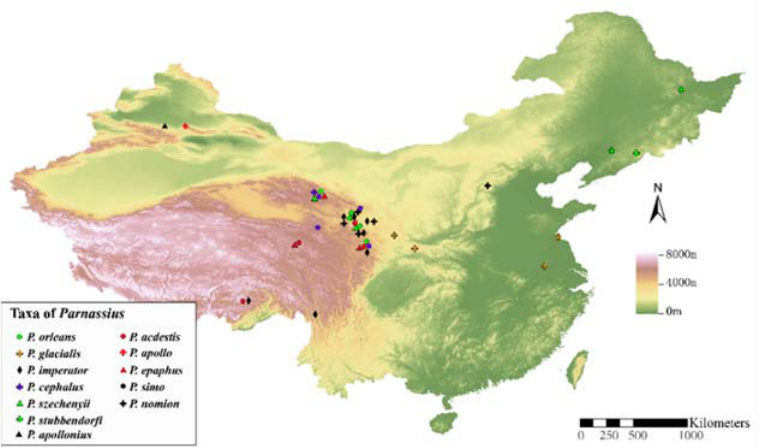
Figure 1. Sample locations of 12 Parnassius species collected in this study.